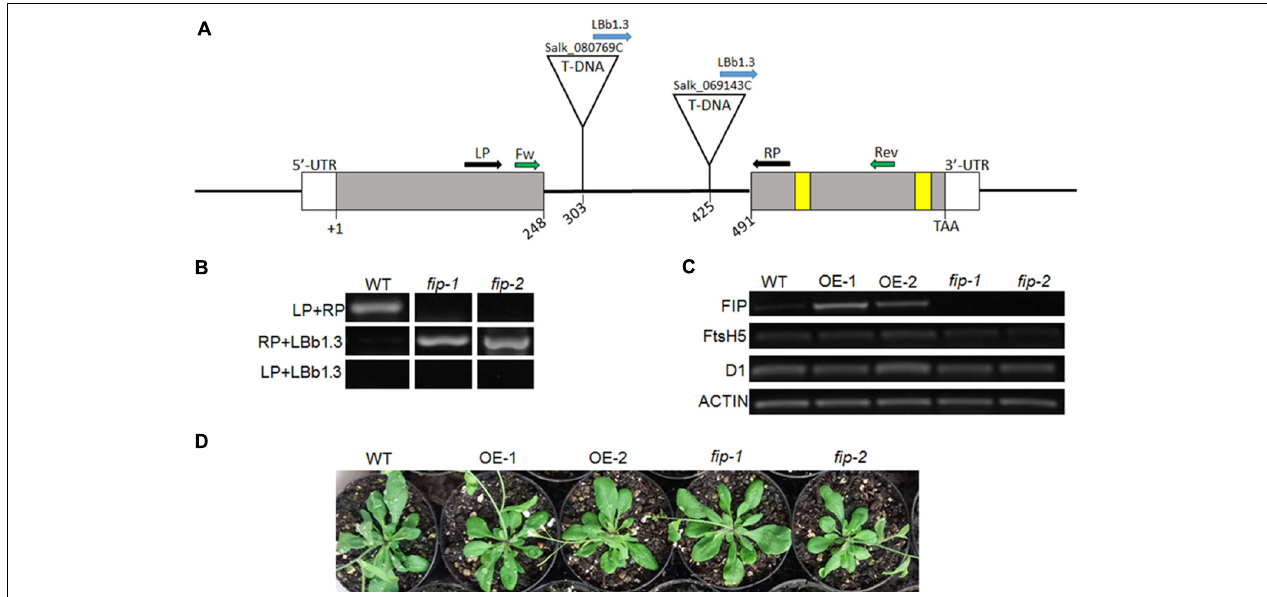
FIGURE 4 | Characterization of FIP plants. (A) Diagram of the FIP gene in Arabidopsis . Exons are depicted as solid gray boxes. The cysteine residues of the zinc-finger domain are represented as yellow boxes. The T-DNA insertion sites in the intron region of the FIP gene (At5g02160) for SALK lines 080769C ( fip-1 ) and 069143C ( fip-2 ) are shown. The annealing sites for the primers are represented by arrows: black pair were used to confirm the mutants along with the blue; green pair were used to RT-PCR analysis. (B) Confirmation of mutants knockdown FIP . A 307 pb fragment was amplified using de LP and RP in wild-type (WT) plants. A 512 or 390 pb fragment was amplified using de RP and LBb1.3 in homozygous plants of the mutants fip-1 and fip-2 , respectively, and no amplification was expected using the LP and LBb1.3 primers, considering an upstream orientation of the T-DNA insertion. (C) Profiles of FIP , FtsH5 , and D1 mRNA accumulation in WT, OE lines, and fip knockdown mutant plants growing under control conditions for 21 days. Total RNA was isolated from leaves of Arabidopsis thaliana . cDNA synthesis was performed using 1 µ g of total RNA. RNA accumulation was determined by semi-quantitative PCR analysis. ACTIN gene expression was used as a control. (D) Phenotypes of three-week-old WT plants, overexpressing (OE) lines, and fip knockdown mutants growing under control conditions (22 ◦ C, 16 h/8 h light/dark, 120 µ mol m − 2 s − 1